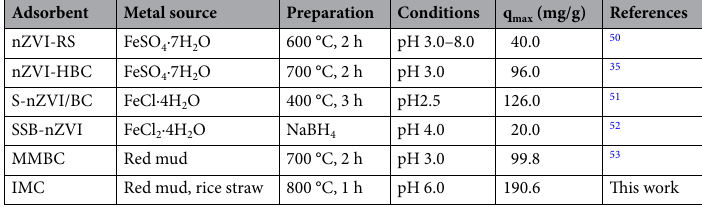
Table 2. Comparison of parameters of different materials for Cr(VI) adsorption.